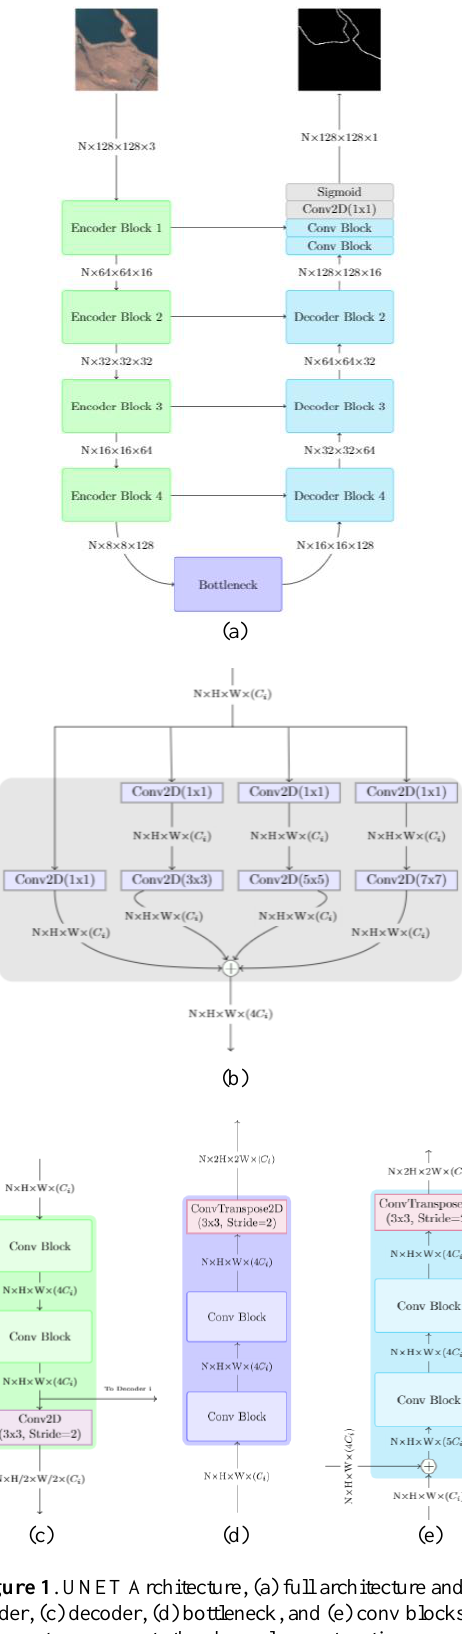
Figure 1 . UNET Architecture, (a) full architecture and (b) encoder, (c) decoder, (d) bottleneck, and (e) conv blocks. The ⊕ operator represents the channel concatenation